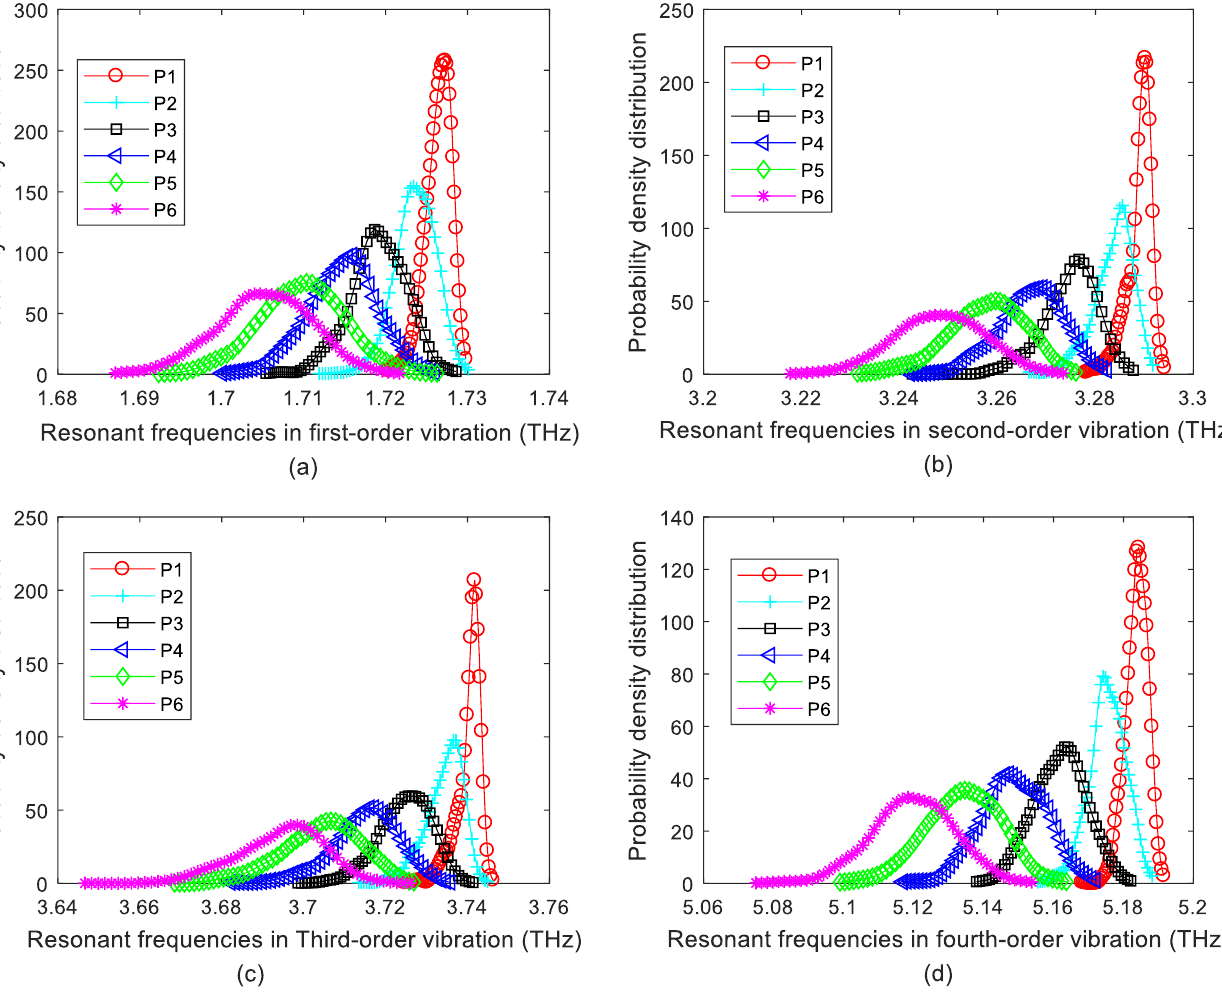
Figure 3. Probability density distribution of resonant frequencies for porous graphene (P1–P6 are for the 0.1%, 0.3%, 0.6%, 0.9%, 1.2% and 1.5% of atomic vacancy defects, respectively; ( a – d ) are for the first-order, second-order, third-order and fourth-order resonant vibration, respectively). Table 2. Statistical results of resonant frequencies for porous graphene with bond vacancy defects.